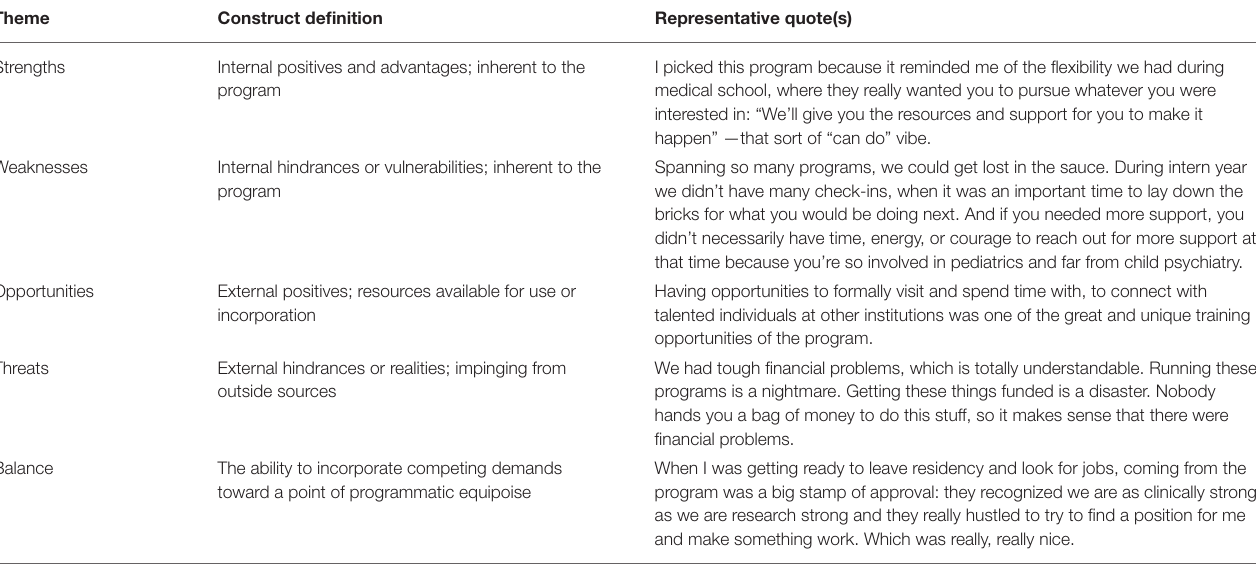
TABLE 3 | Program characteristics: SWOT-B